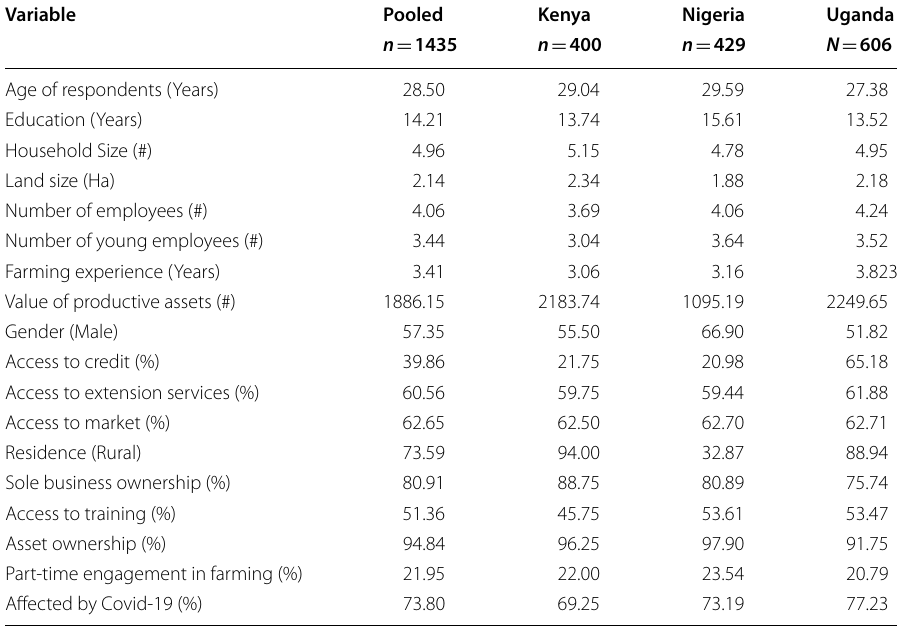
Table 2 Descriptive statistics for the socioeconomic and demographic characteristics of the